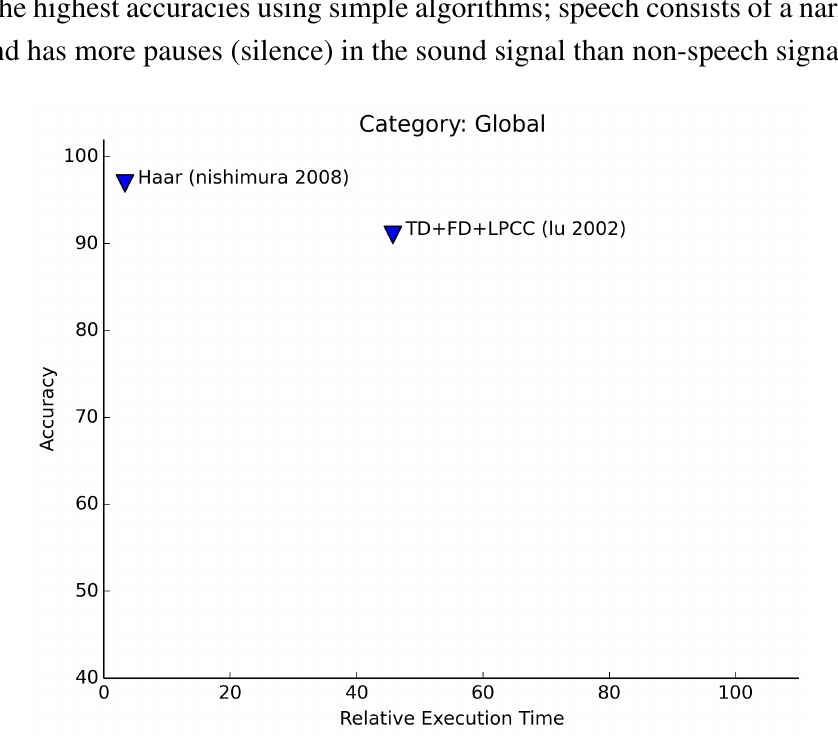
Figure 6. Relative execution time for global sound